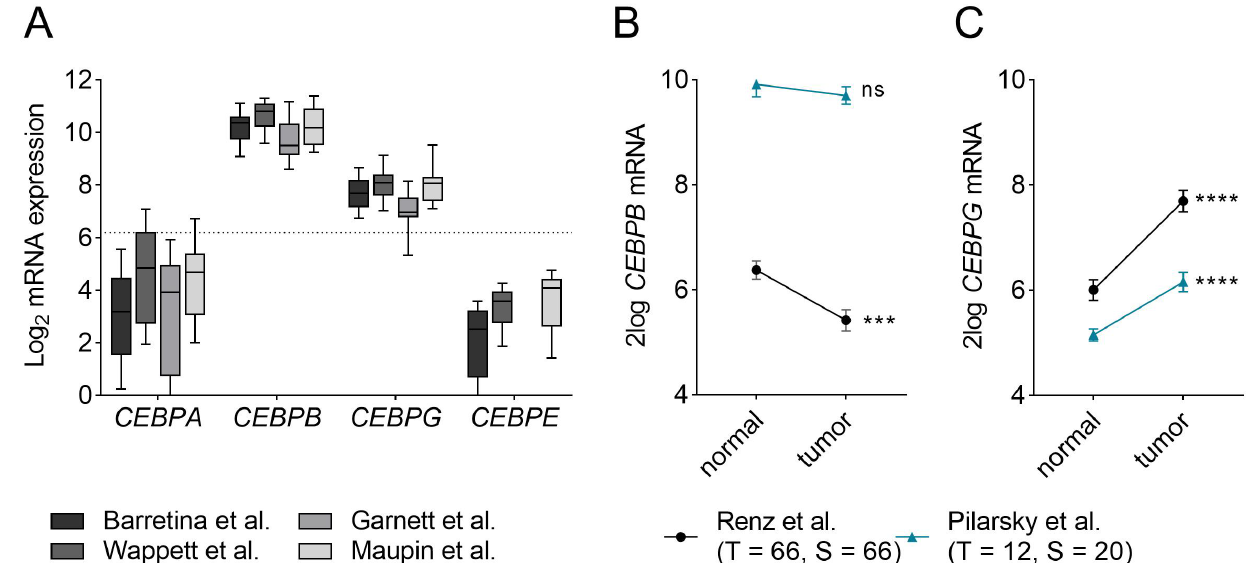
Figure 1. mRNA expression of CEBP -members in PDAC. ( A ) mRNA expression of CEBPA , CEBPB , CEBPG and CEBPE in different PDAC cell line panels published by Barrettina et al. ( n = 43) [26], Garnett et al. ( n = 17) [27], Wappett et al. ( n = 41) [28] and Maupin et al. ( n = 22) [29]. While CEBPA and CEBPE are lowly expressed, CEBPB and CEBPG are relatively highly expressed. Dotted line marks the median expression of all genes in the four datasets (Y = 6.19). ( B , C ) mRNA expression of ( B ) CEBPB and ( C ) CEBPG in microdissected tumor and stromal cells in the Renz—(black) [24] and Pilarsky—(blue) [25] dataset. Shown is the mean ± SEM. Levels of significance: ns = not significant, *** p < 0.001 and **** p < 0.0001. Abbreviations: T = tumor samples; S = stromal samples; n = normal tissue samples.